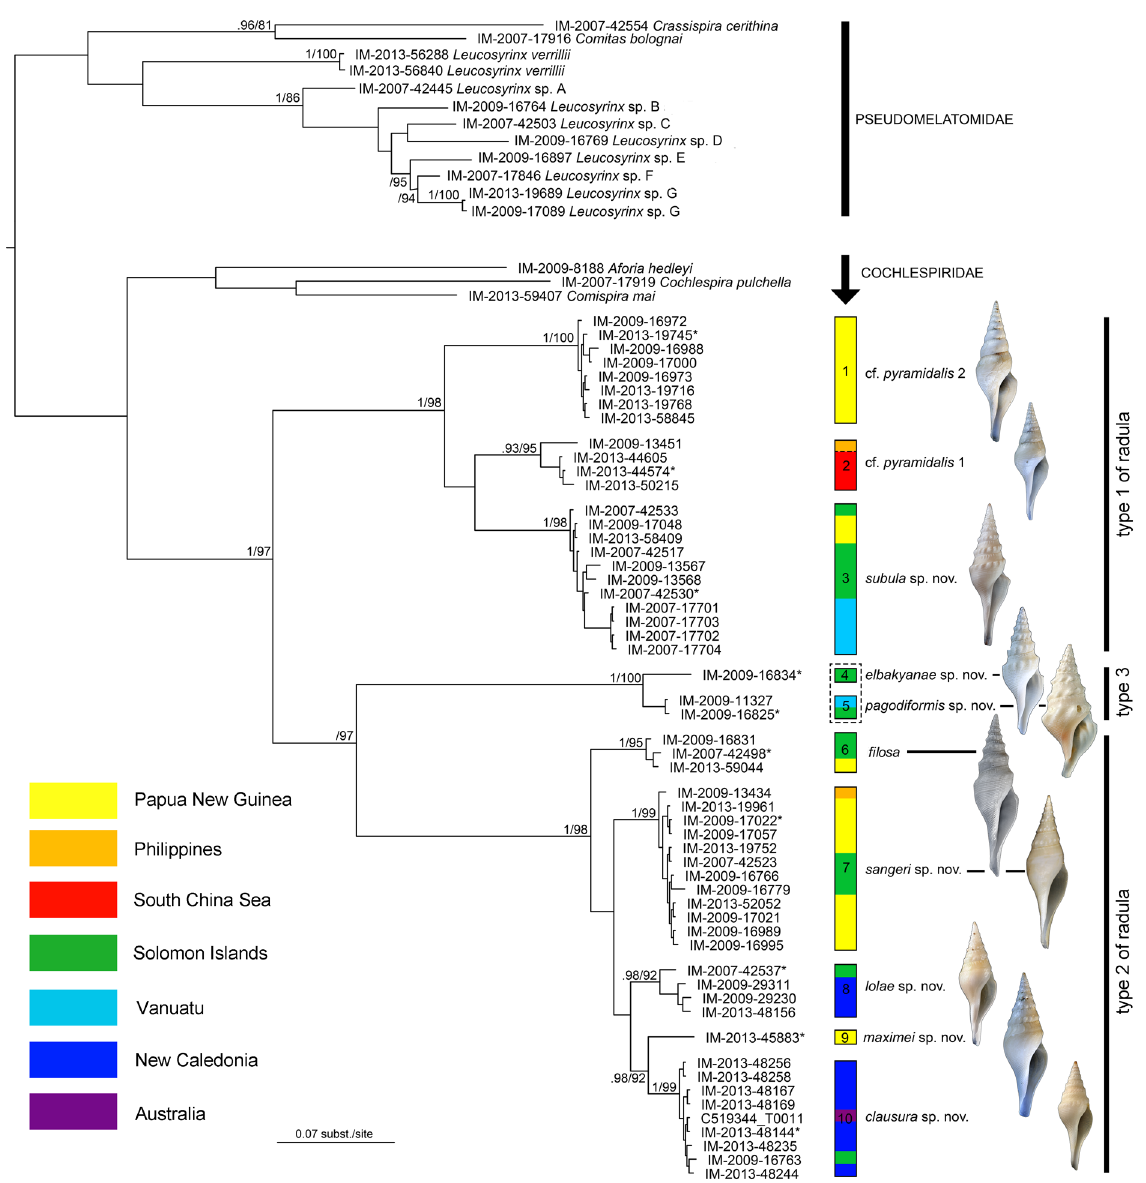
Fig. 1. Bayesian phylogenetic tree obtained with the cox1 dataset. Posterior probabilities (> 0.95) and bootstraps (> 90) are shown for each node. The boxes in front of the lineages of Sibogasyrinx Powell, 1969 represent the ABGD PSHs, numbered from 1 to 10. Alternative PSH partitions obtained in the second and third-best ASAP partitions are shown with dashed lines. The colors refer to the locality; * = illustrated